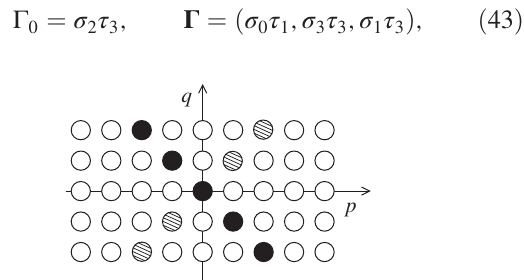
FIG. 7. The full bulk classifying group K ð 2 ; 1 Þ for classes A CM is Z 2 . The purely crystalline subgroup K 0 ð 2 ; 1 Þ and the separable subgroup ker ω are denoted by solid and hatched circles,